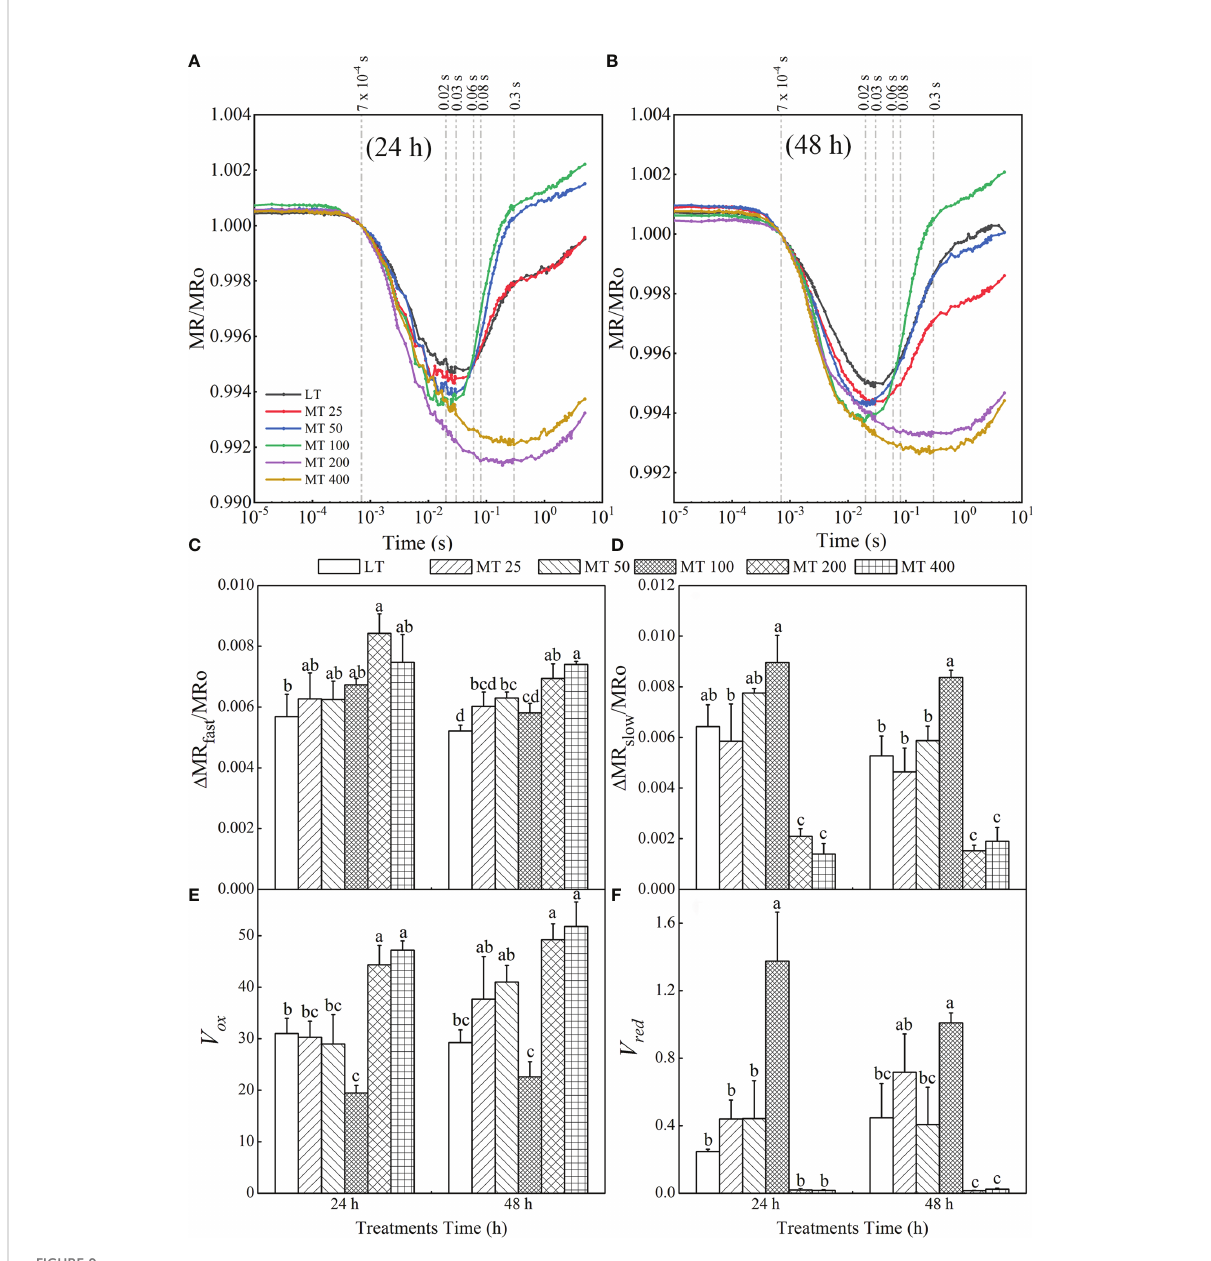
FIGURE 9 Effect of melatonin (MT) on the MR 820 signal after low temperature stress for 24 h (A) and 48 h (B) . The time point 7×10 -4 s represents the fi rst reliable value of the MR/MRo (MR O ) of each treatment; the time point 0.02 s represents the MR min of MT 50 and MT 100 treatments, the time point 0.03s represents the MR min of LT and MT 25 treatments, the time point 0.06s represents the end of V red in MT 50 and MT 100 treatments, the time point 0.08 s represents the end of V red in LT and MT 25 treatments, the time point 0.3 s represents the MR min of MT 200 and MT 400 treatments, and the time point 0.6 s represents the end of V red in MT 200 and MT 400 treatments. The fast phase (C) was calculated as – MR △ MR – MR △ MR fast /MR O = |(MR O min )|/MR O . The slow phase (D) was calculated as slow /MR O =(MR O max )|/MR O . The oxidation rate of plastocyanin (PC) and PSI reaction center (P 700 ) (E) was achieved: V ox = △ MR/ △ t = (MR 2ms – MR 0.7 ms )/(1.3 ms). The reduction rate of PC + and P 700 + (F) was calculated as V red = △ MR/ △ t. The V red of LT and MT 25 treatments were calculated by V red = (MR 80ms – MR 30ms )/(50 ms); The – MR V red of MT 200 and MT 400 treatments V red of MT 50 and MT 100 treatments were calculated by V red = (MR 60ms 20ms )/(40 ms); and The were calculated by V red = (MR 600ms – MR 300ms )/(300 ms). In this experiment, the MR of each treatment did not reach the maximum value, so the last value of MR was taken as MR max . The values were represented by the means ± SE. The same letters denoted that there is no signi fi cant difference at P < 0.05 according to Duncan ’ s